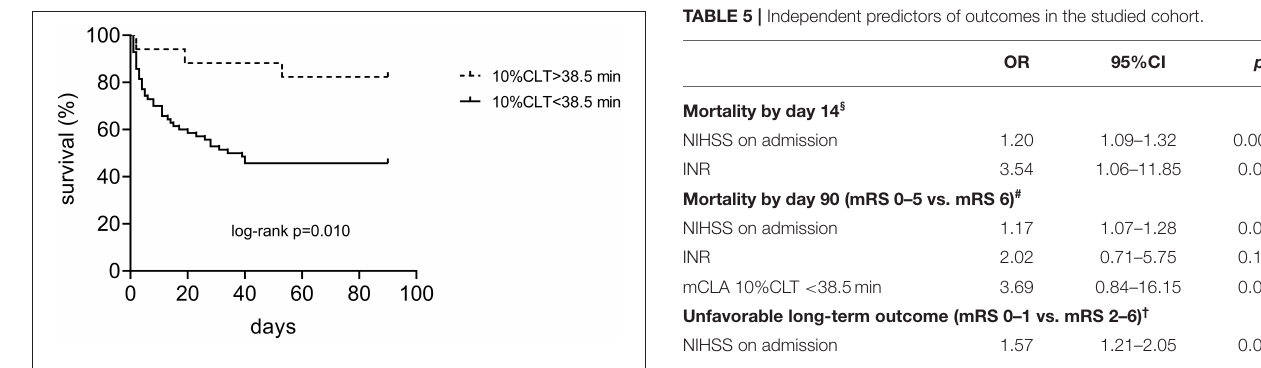
FIGURE 5 | Kaplan-Meier survival curves of patients with spontaneous intracerebral hemorrhage according to the result of the modified clot lysis assay on admission (10%CLT below and above the limit of 38.5min).